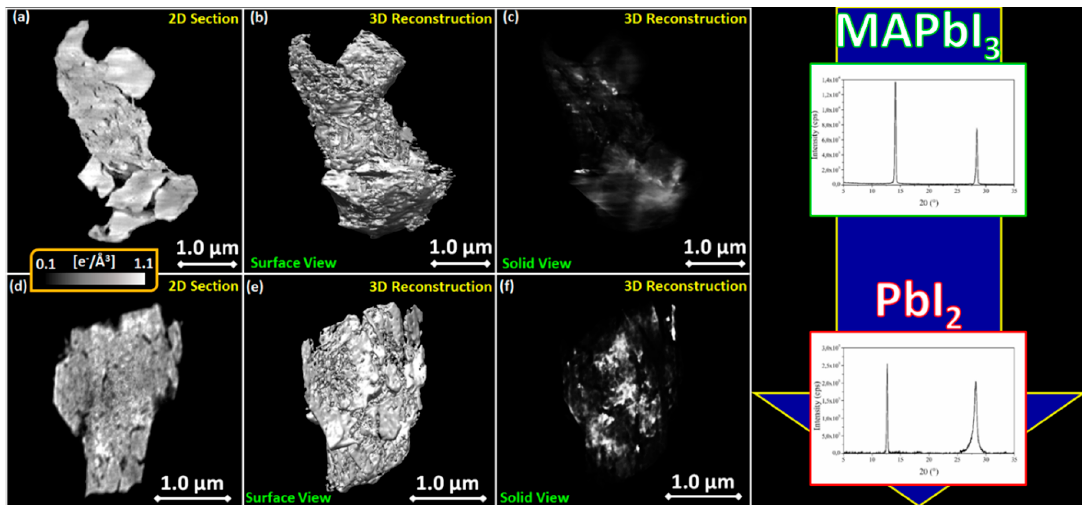
Figure 4. CXDI images of ( a – c ) a blend of TiO 2 and MAPbI 3 ; ( d – f ) a blend of TiO 2 and PbI 2 . The brilliant zones in ( c , f ) correspond to material with high electronic density ( > anatase, TiO 2 ). As representative of the others, in( f ) the brilliant rows (regions of density above 0.9–1 e − / Å 3 ) of PbI 2 embedded into the matrix mark the infiltration path of MAPbI 3 into the vertical meso-pipelines. The color bar refers to all 2D sections.